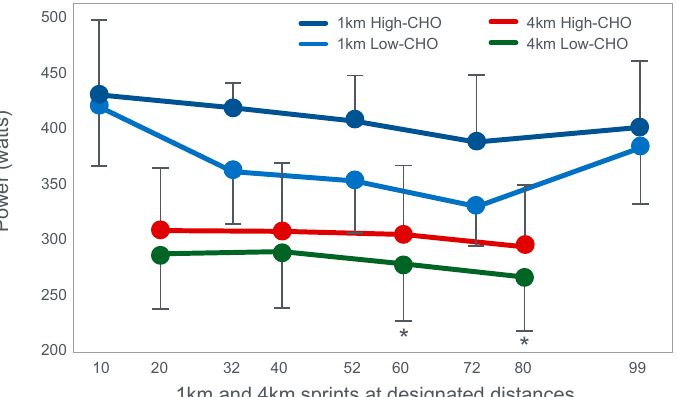
Figure 27. Power outputs during either 1 or 4 km sprints interspersed within a 100 km laboratory cycling time trial when athletes ate either the low-carbohydrate or high-carbohydrate diets for six days followed by a single day of ‘carbohydrate loading’. Adapted with permission from ref. [104]. Copy-right 2006 American Physiological Society.